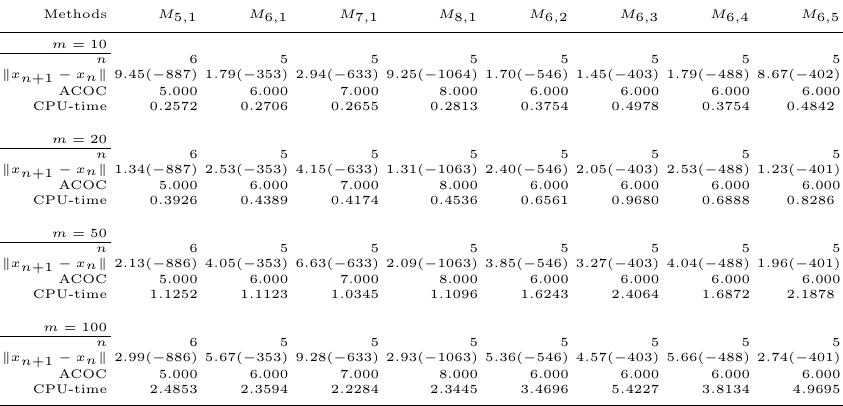
Table 5. Comparison of performance of methods for Problem 2